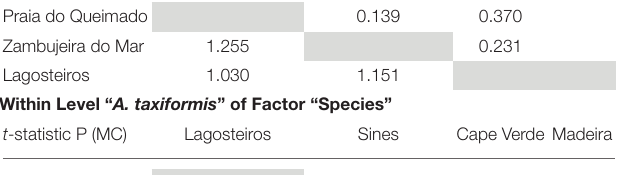
TABLE 2 | Results of PERMANOVA main test with Square root transformation and Bray-Curtis distances. Source of Variation Sp × Lo No test No test